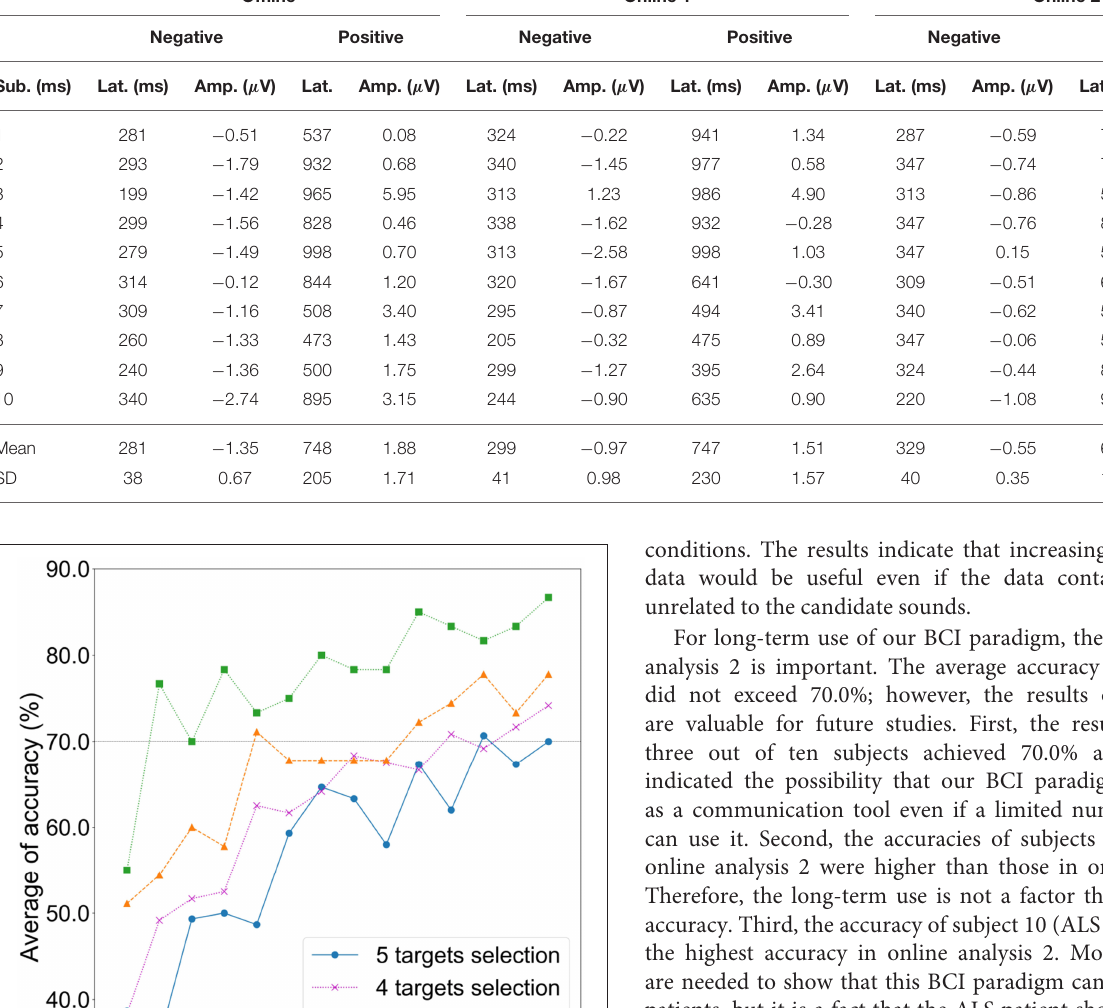
TABLE 6 | Overview of latencies and amplitudes of positive (200–350 ms) and negative (350–1,000 ms) ERP peaks in the offline and online analyses. Offline